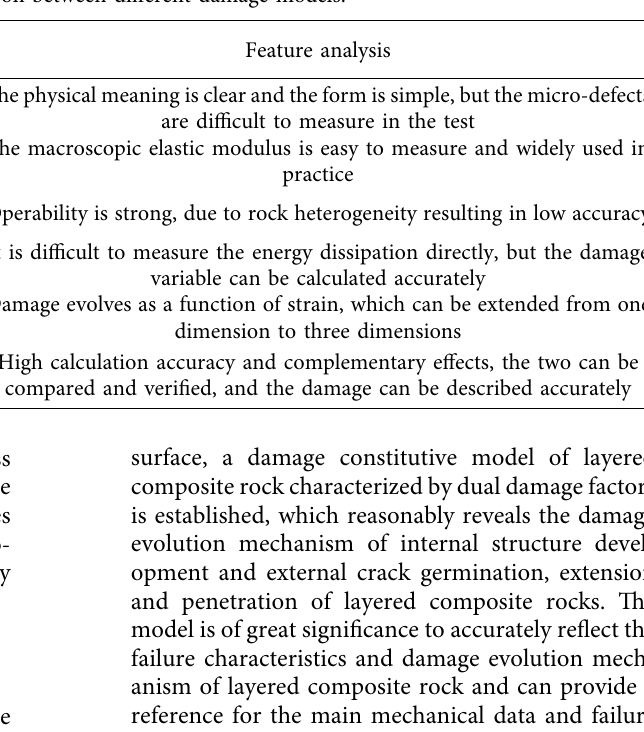
Table 5: The feature comparison between different damage